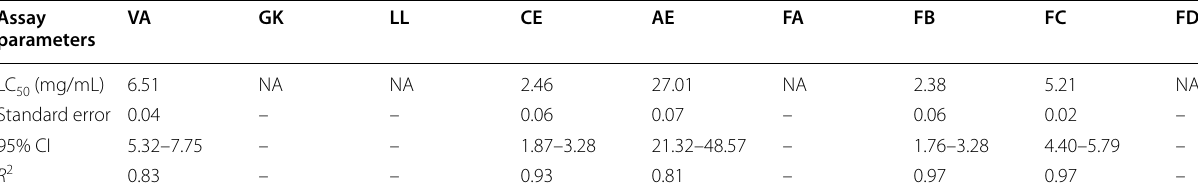
VA Vernonia amygdalina , GK Garcinia kola , LL Leucaena leucocephala , CE Chloroform extract of Vernonia amygdalina ; AE Acetone extract Vernonia amygdalina , Chromatographic fractions of CE (FA, FB, FC, FD)